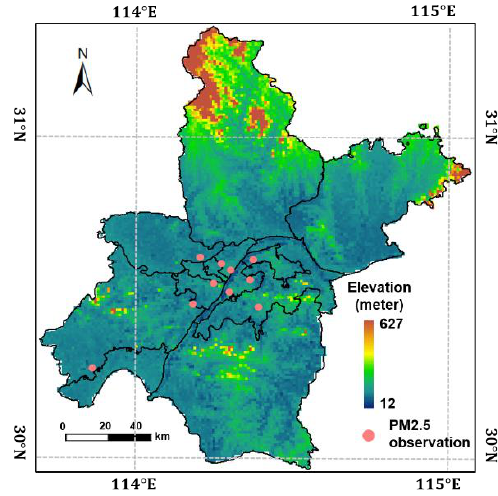
Figure 1. Study area and 10 in-situ PM2.5